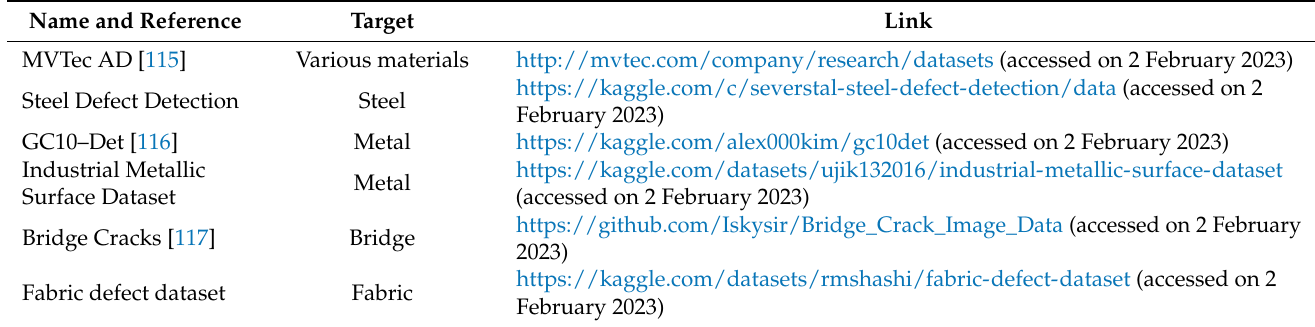
Table 5. A list of common surface defect datasets with classifications for industrial